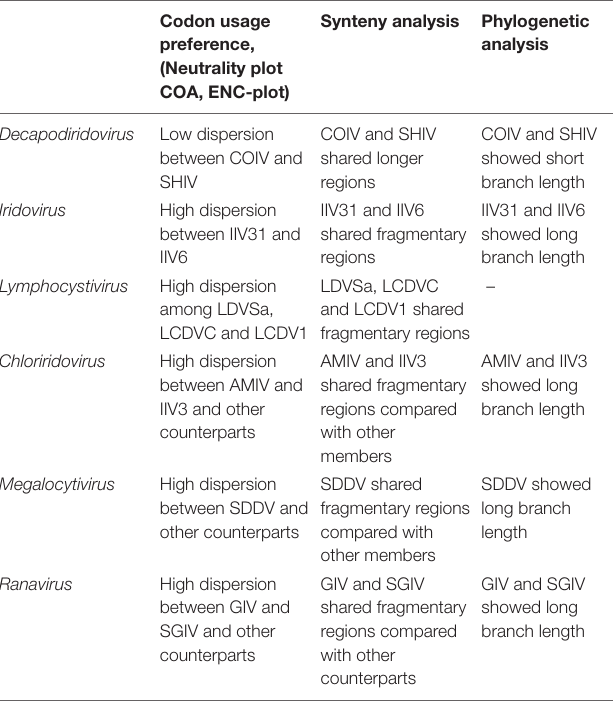
TABLE 2 | Comparison of codon usage preference, synteny analysis and phylogenetic analysis between different genera in the family Iridoviridae. Codon usage